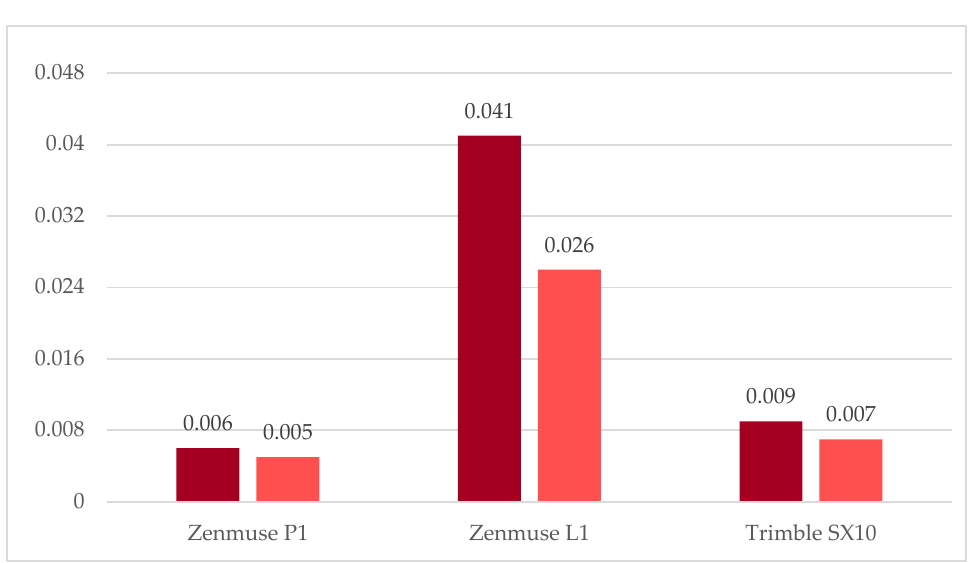
Figure 37. Roughness analysis: RMSe (m) in dark red; deviation (m) in light red. The point clouds also displayed significant differences related to RGB restitution: the 45-megapixel full-frame sensor of the P1 camera was able to process and return faithful colours of the castle and the context (terrain and vegetation), while the L1 and SX10 incorporated cameras (20 and 5 megapixels, respectively, not full-frame sensor) captured more approximate colours. Having LiDAR sensors, the L1 and SX10 also captured more noise and light reflections.